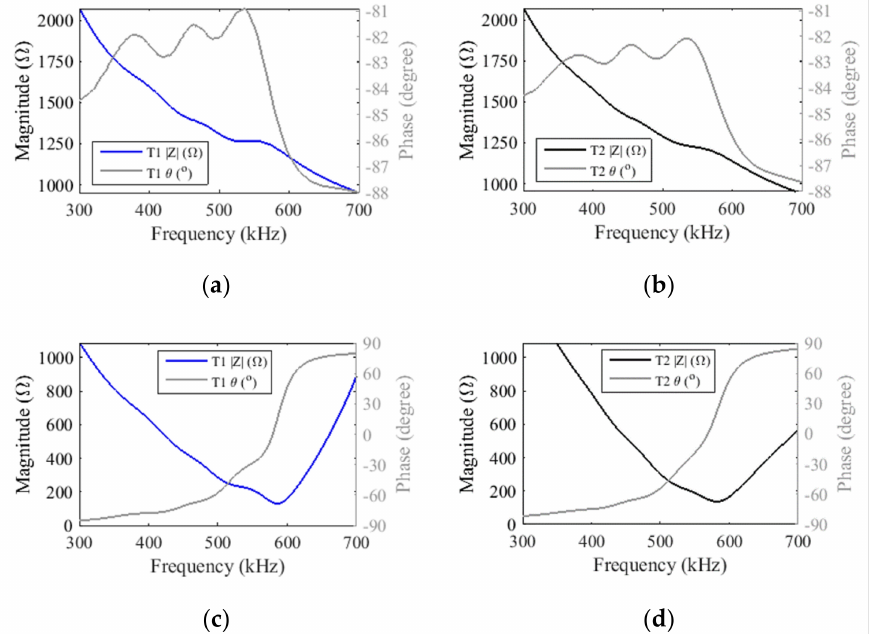
Figure 12. Electrical impedance magnitudes and phases of element (2,3) measured for mismatched transducers: ( a ) T1 and ( b ) T2: and for transducers with a series inductor: ( c ) T1 and ( d ) T2. Transducer T1 has air backing and transducer T2 has epoxy resin backing.